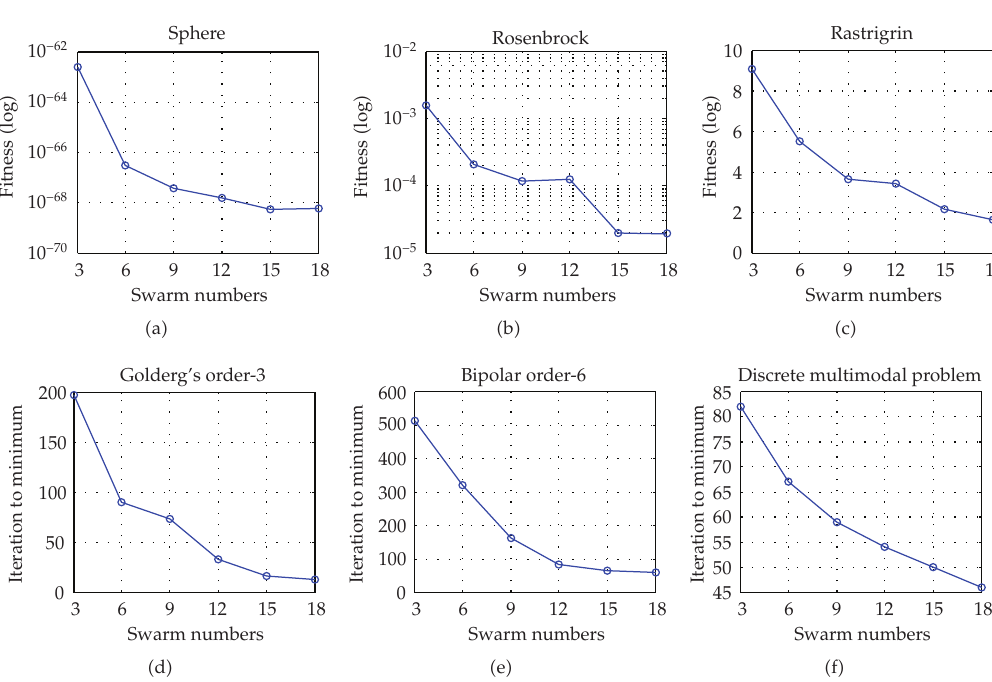
Figure 8: PS 2 O’s results on six test functions with di ff erent swarm number M